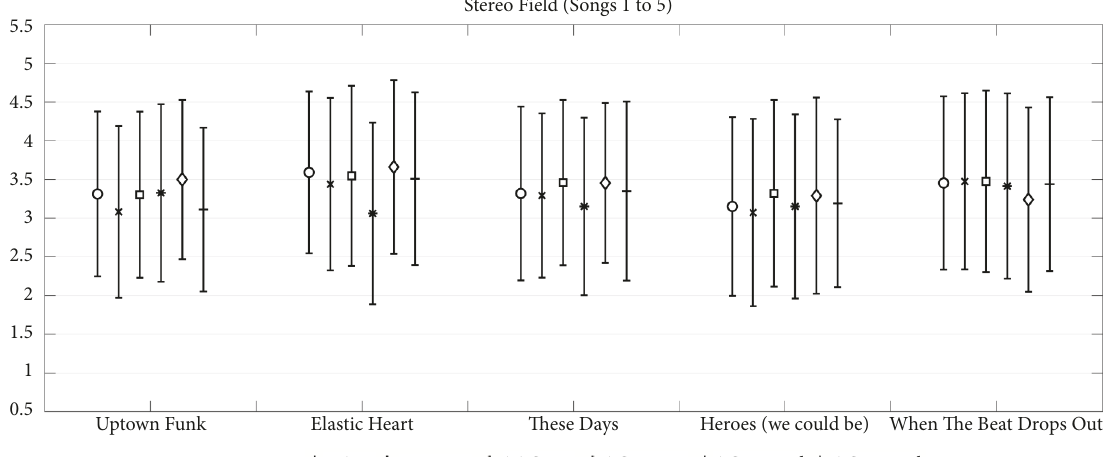
Figure 4: Stereo field results (songs 1 to 5). A score of 1 represents narrow and imprecise and a score of 5 represents wide and precise.